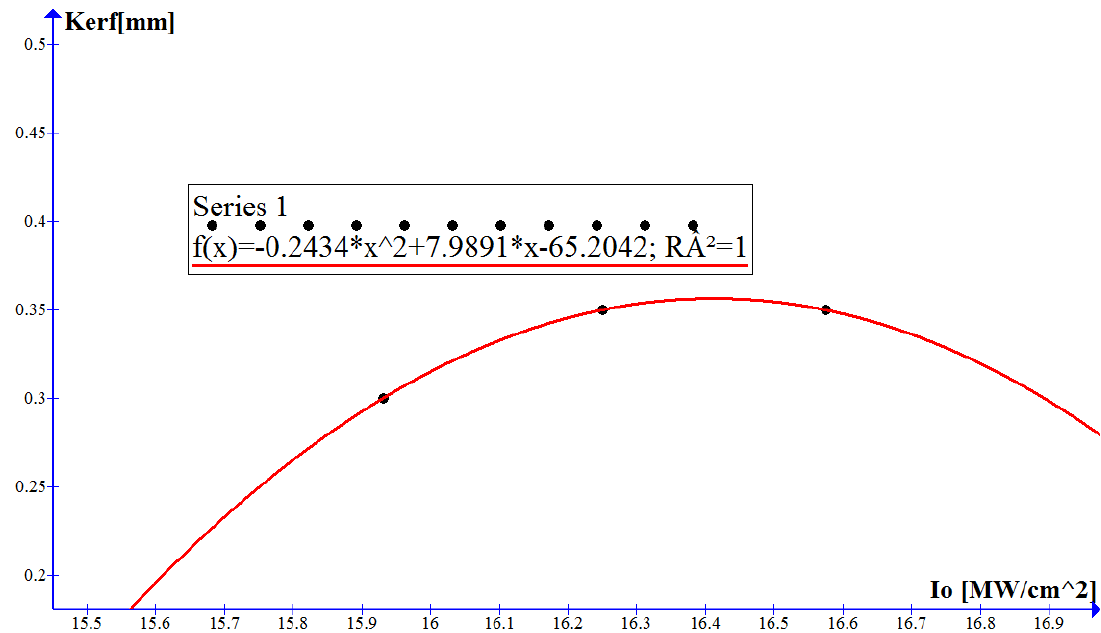
Figure 7. Dependence of cutting width depending on the incident laser